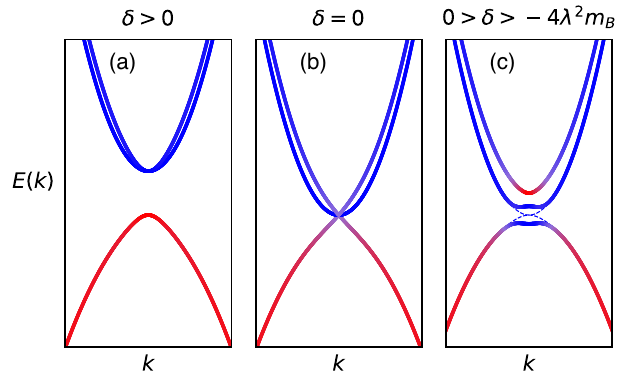
FIG. 3. Band structure of the effective theory [Eq. (12)] near inversion. The band colors indicate the sublattice content: blue for A and red for B bands. Panels (a) and (b) show bands before and at inversion. After inversion, the g ¼ 0 bands feature a quadratic band touching (dashed lines), shown in panel (c). A perturbative instability then opens a topological gap for g > 0 , as illustrated. For δ < − 4 λ 2 m (not shown), Fermi surfaces form, and the B system is metallic at g ¼ 0